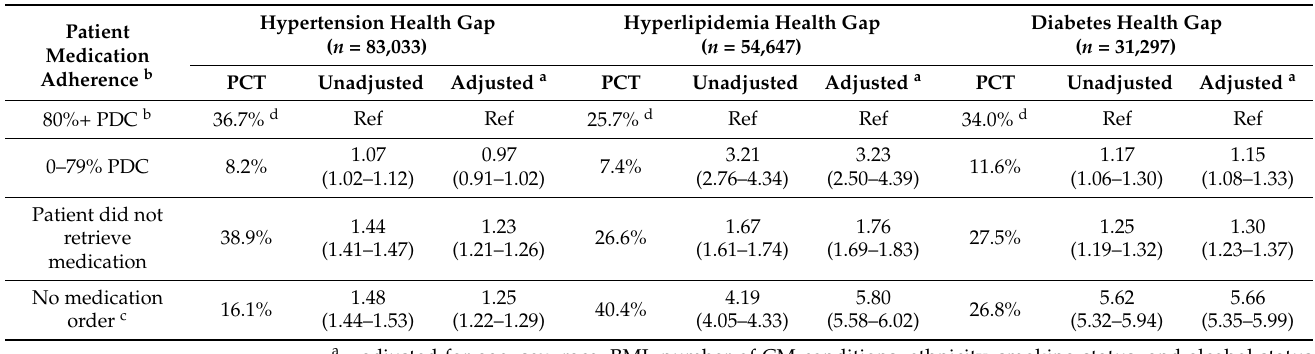
Table 3. Logistic regression model-based estimates of the odds ratio for the relationship between medication adherence, as defined by proportion of days covered (PDC) and patient health gap status with and without adjustment for other covariates a .